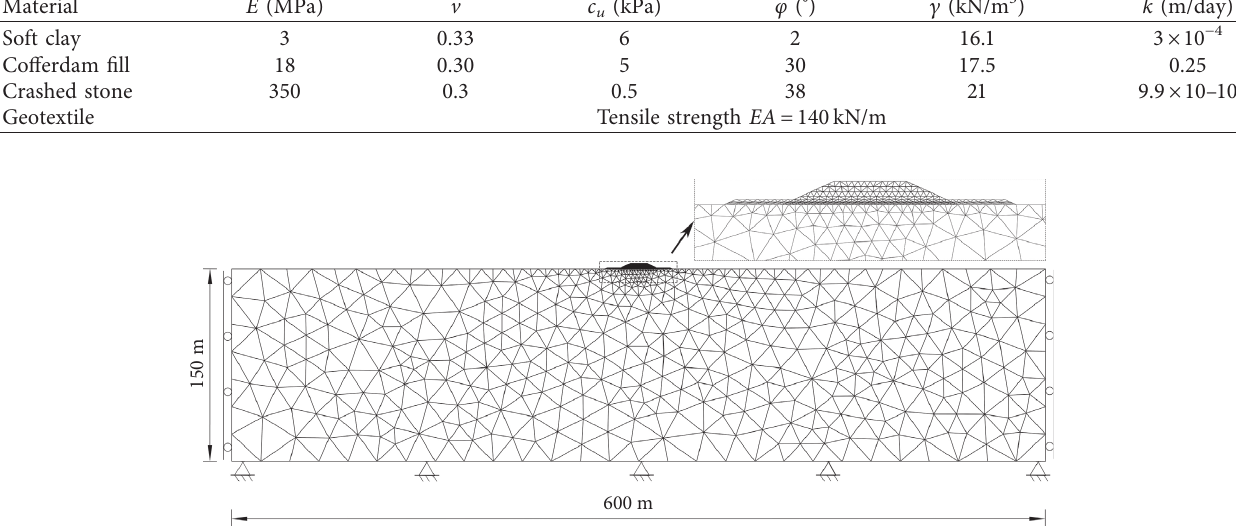
Figure 3: Finite element mesh in the